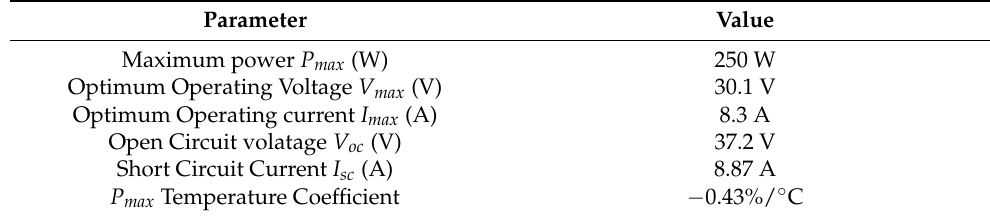
Table 1. The PV module